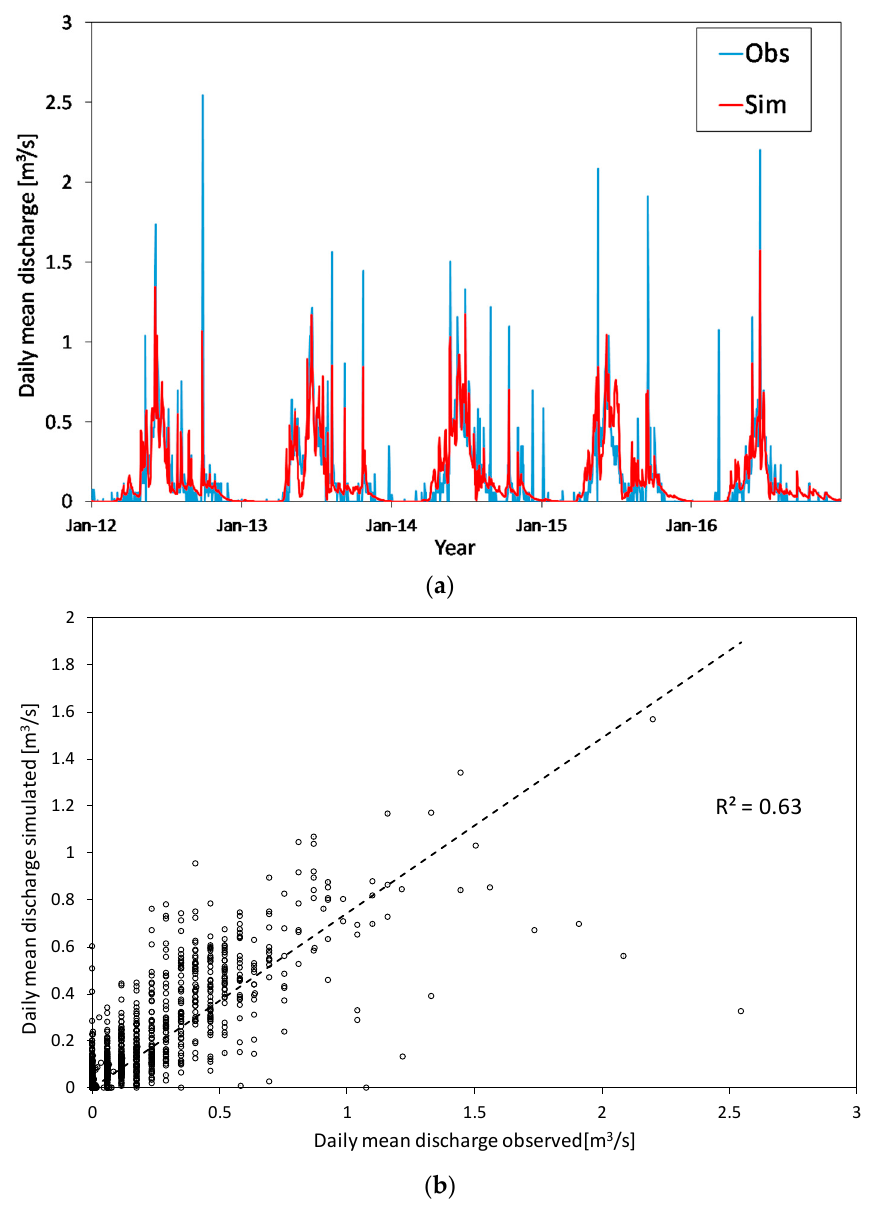
Figure 2. Time series plot ( a ) and comparison ( b ) between the simulated and observed discharge for 2012–2016. R 2 is the correlation coefficient.